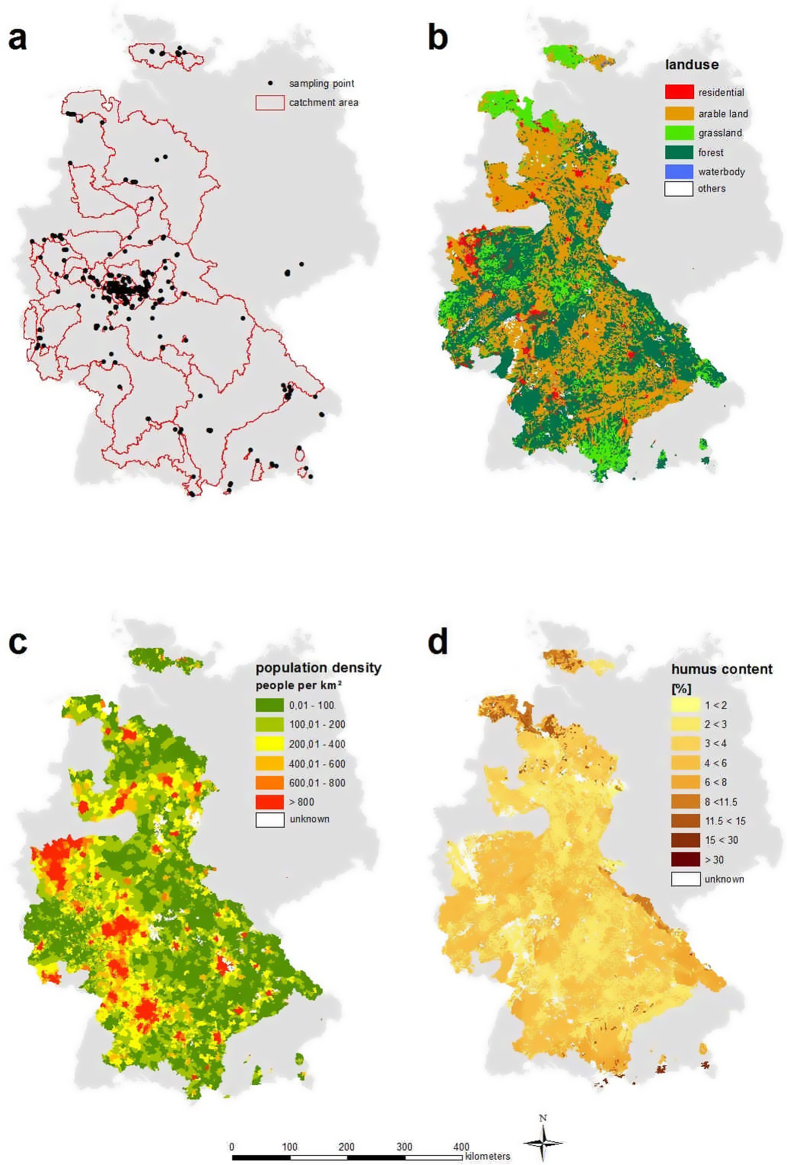
Crowdsourcing area: (a) study area with sampling points and catchment area; (b) main land use classes49; (c) population density52; (d) topsoil humus content48; territory of Germany in grey. Maps were generated with ArcGIS 10.0, ESRI.